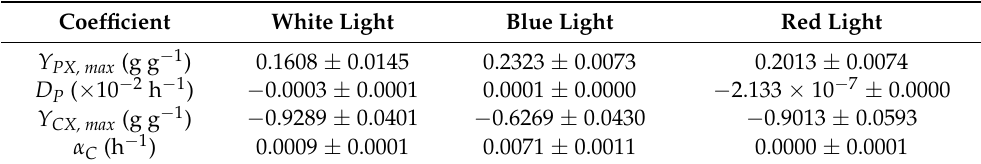
Table 2. Key coefficients of kinetic models for carbon storage in N-recovery. Data are presented in the form of mean ± the standard deviation ( n = 3). Coefficient White